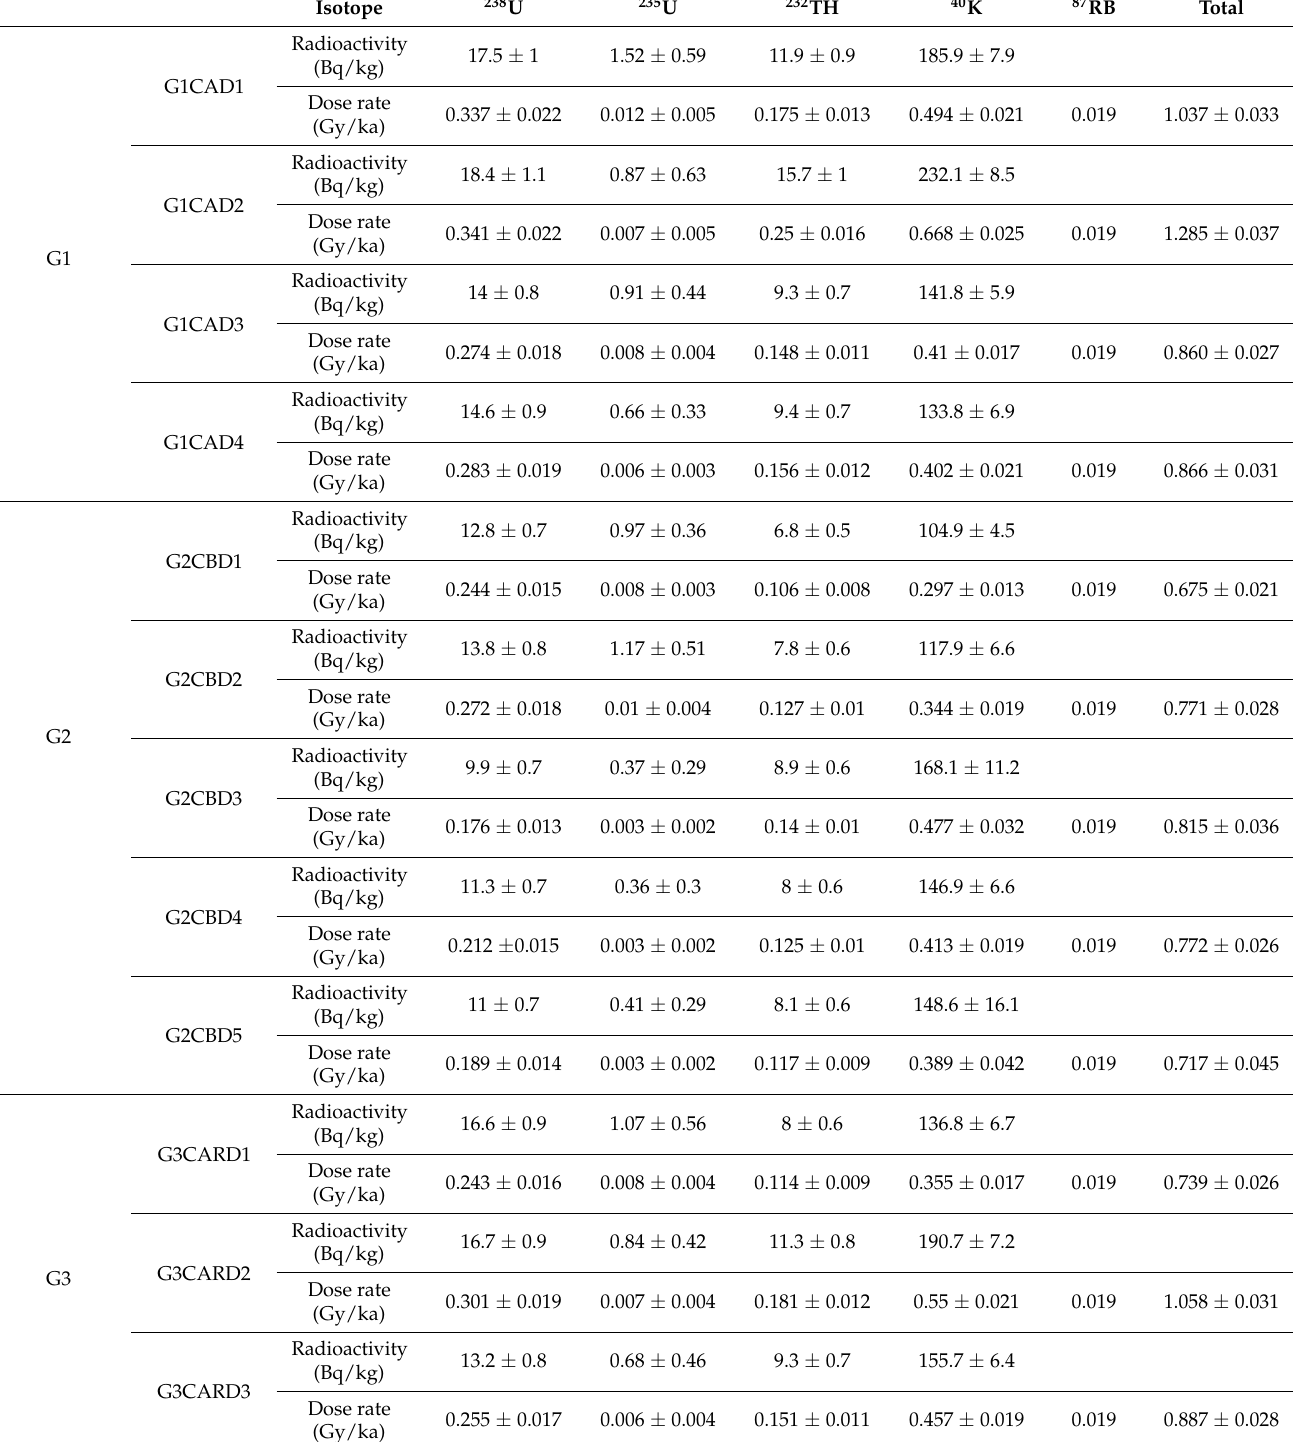
Table 6. Radioactivity measurements and calculated dose rates.